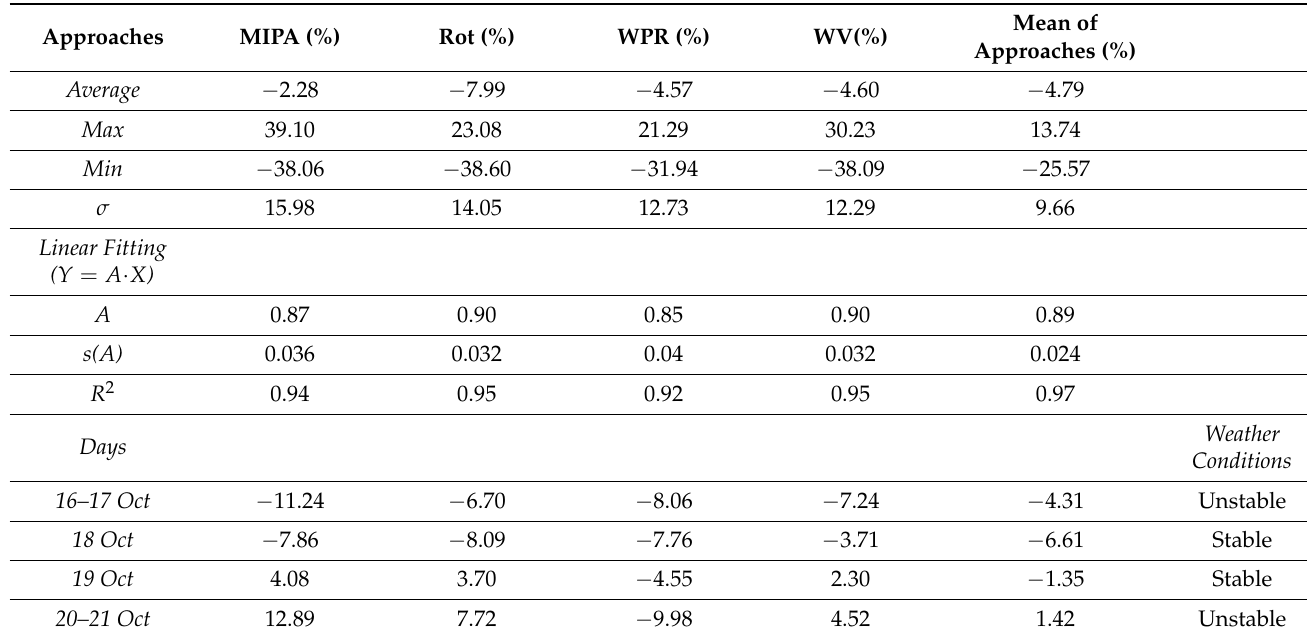
Table 2. Statistical analysis, considering relative biases, of the ABLH estimates obtained with the different approaches/sensors. The linear fitting (Y = A · X) of the compared approaches versus radiosondes (on site) is also